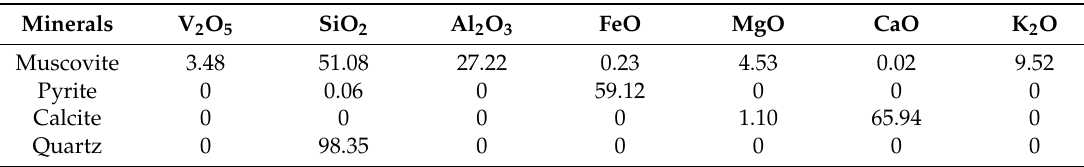
Table 2. EPMA result of stone coal ore wt